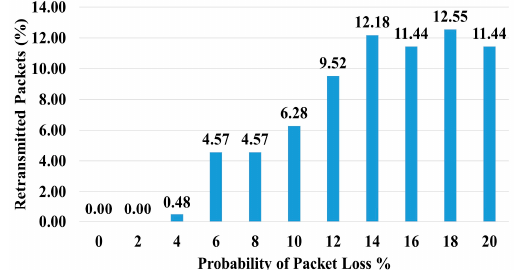
Figure 15. Number of Retransmitted Packets vs. Probability of Packet Loss.